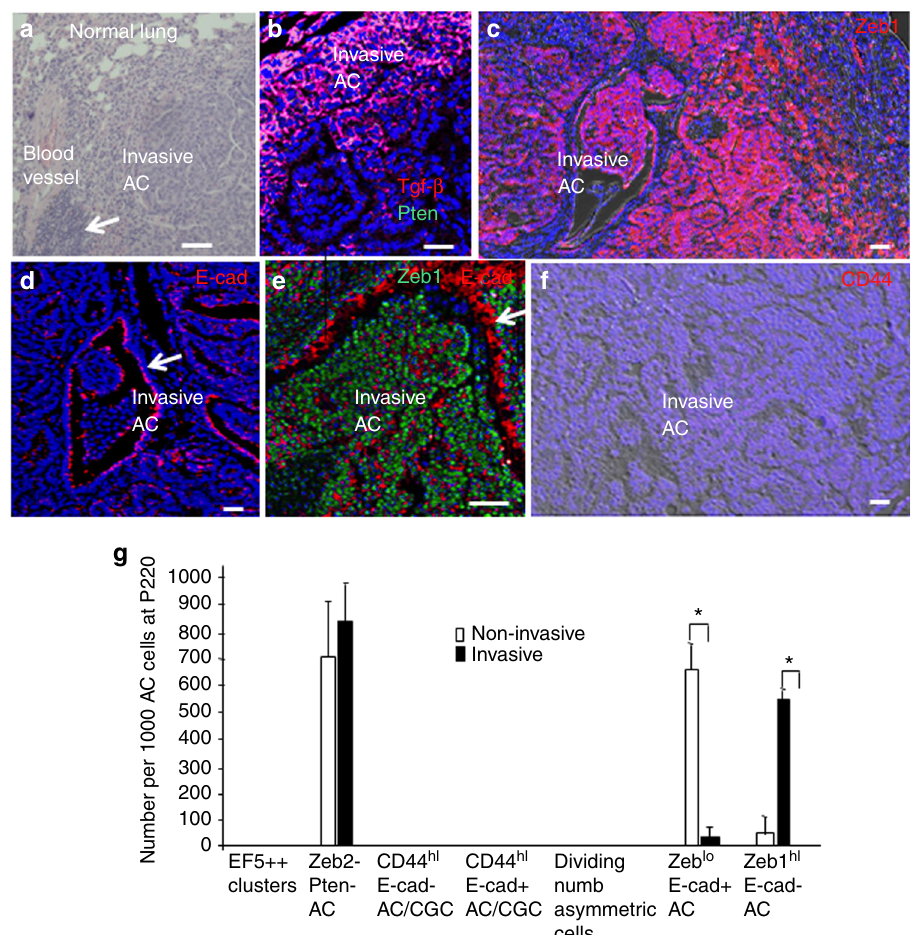
Fig. 7 Invading cancer cells display plastic EMT, but fail to induce CD44 or show properties of CGC. a Sites of airway invasion show in fl ammation (arrow). b Sites of tumor invasion are Tgf- β 1-rich and remain Pten − . c Zeb1 is re-induced in tumor cells at sites of airway invasion. d E-cadherin (E-cad) is repressed in tumor cells at sites of airway invasion, but it is maintained in airway epithelial cells (arrow). e Higher power view of Zeb1 + , E-cad − tumor cells invading an airway. The arrow indicates E-cad + airway epithelial cells. f Invading tumor cells continue to be CD44 lo . g Quanti fi cation of cell morphology, expression, and division patterns in invasive and non-invasive tumors. n = 18 at P220. Bars are 50 μ